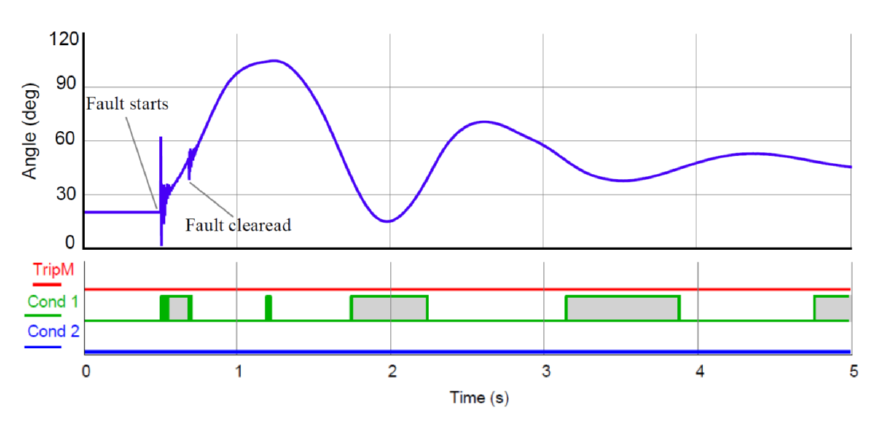
Figure 4. Stable case against an 11-cycle fault: the voltage angle difference between bus 1 and bus 5, the evolution of the power condition in green, the angle condition in blue, and the tripping signal in red.